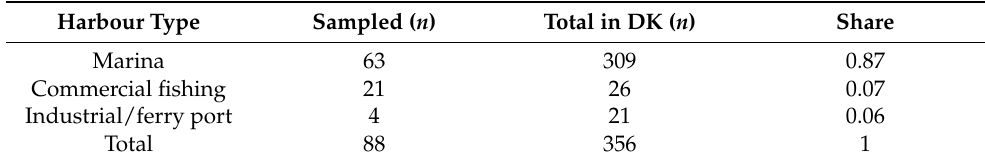
Table 2. Overview of the harbours in Denmark, total number, number sampled and the share of each type.